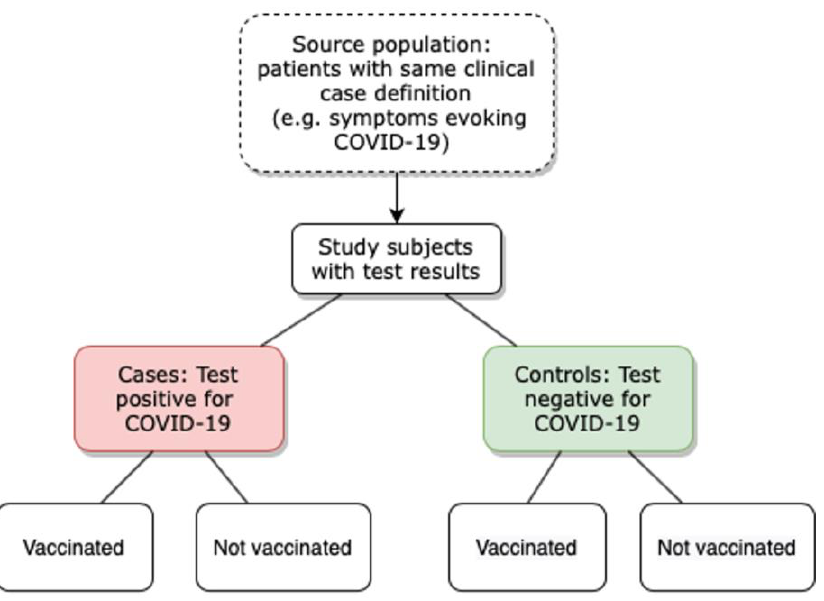
Figure 1. Principles of test-negative design in COVID-19 vaccine studies.